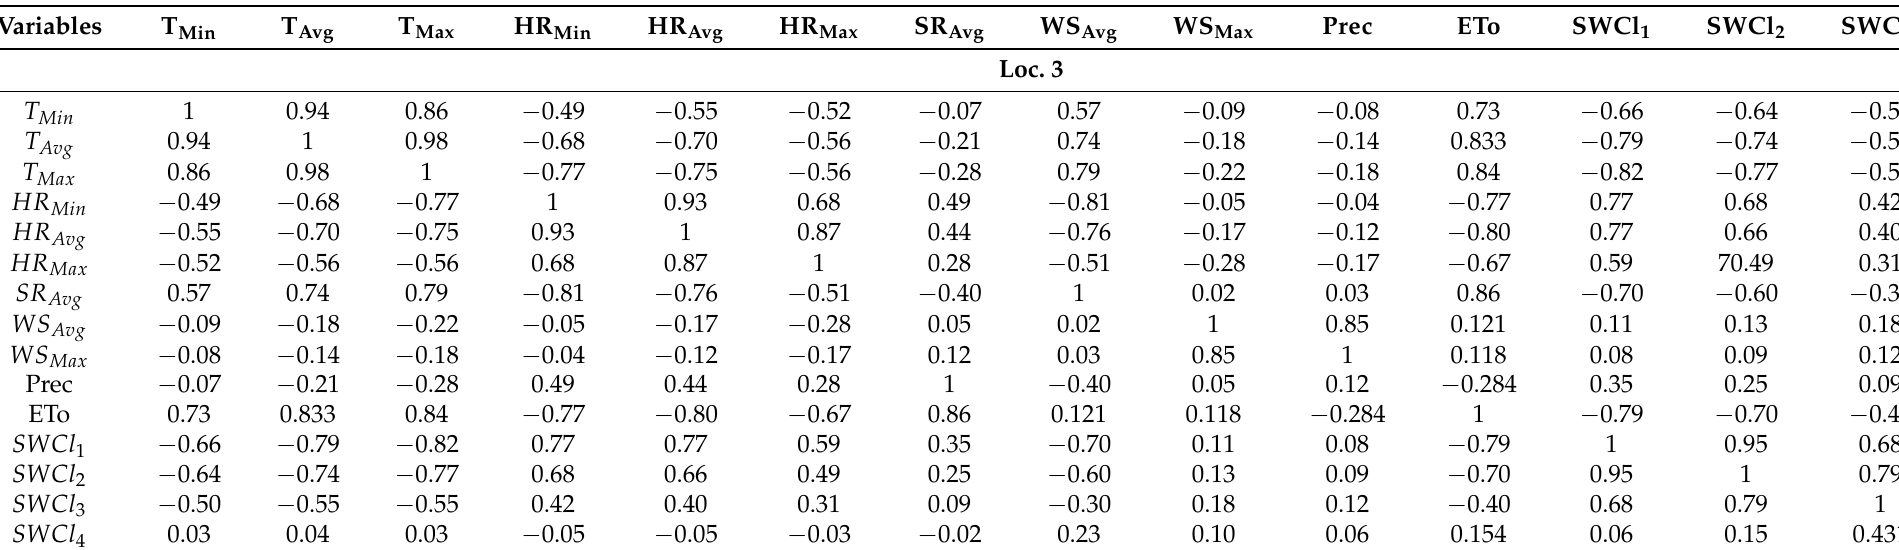
Table A3. Collinear coefficient between parameters in dataset (Loc.